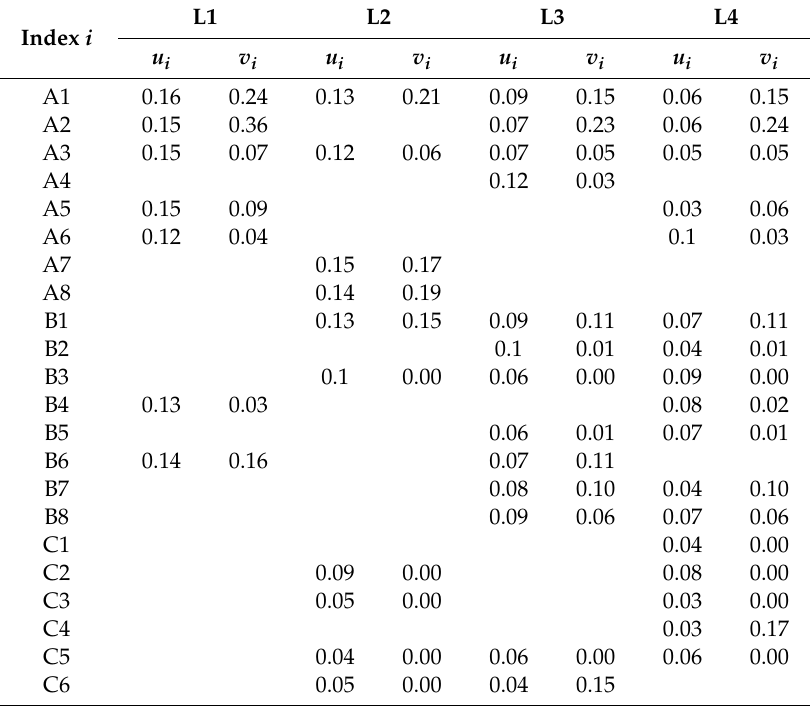
Table 4. The weights of each stakeholder obtained by order relation method and Gini coe ffi cient weighting method. Index